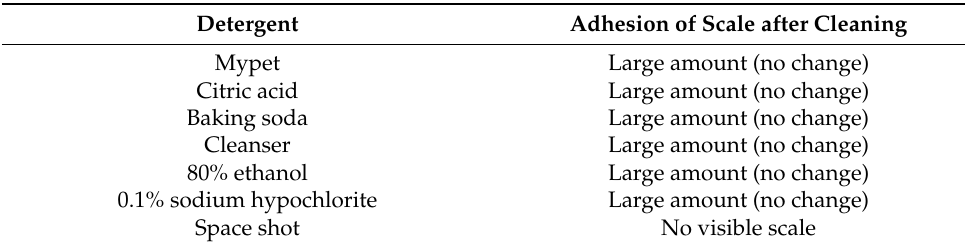
Table 2. Effectiveness of various detergents at removing hard scale around the washbasin tap.